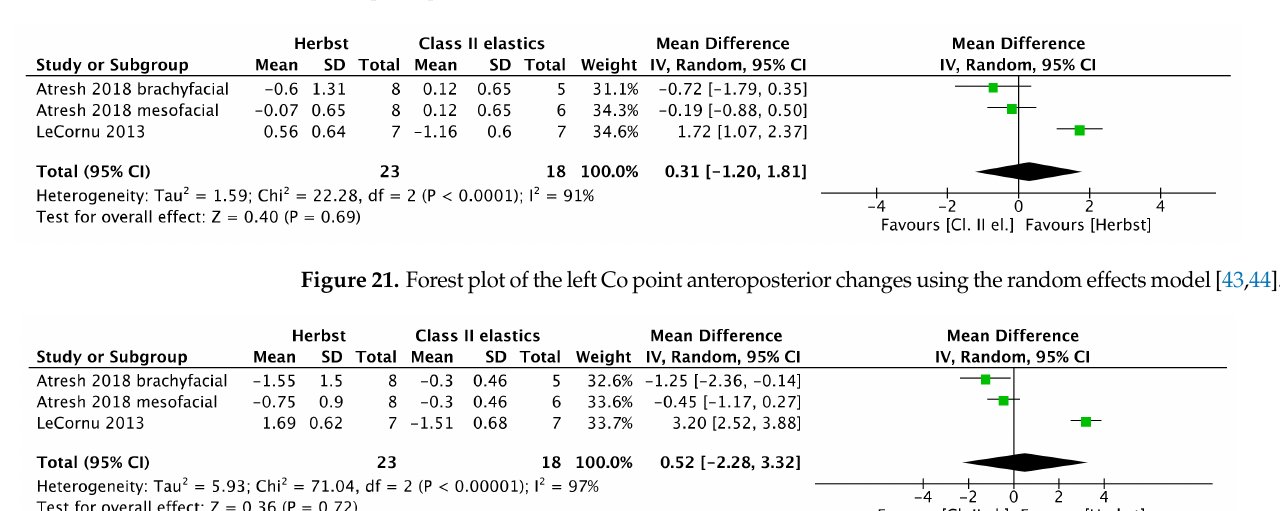
Figure 20. Forest plot of the right Co point anteroposterior changes using the random effects model [43,44].